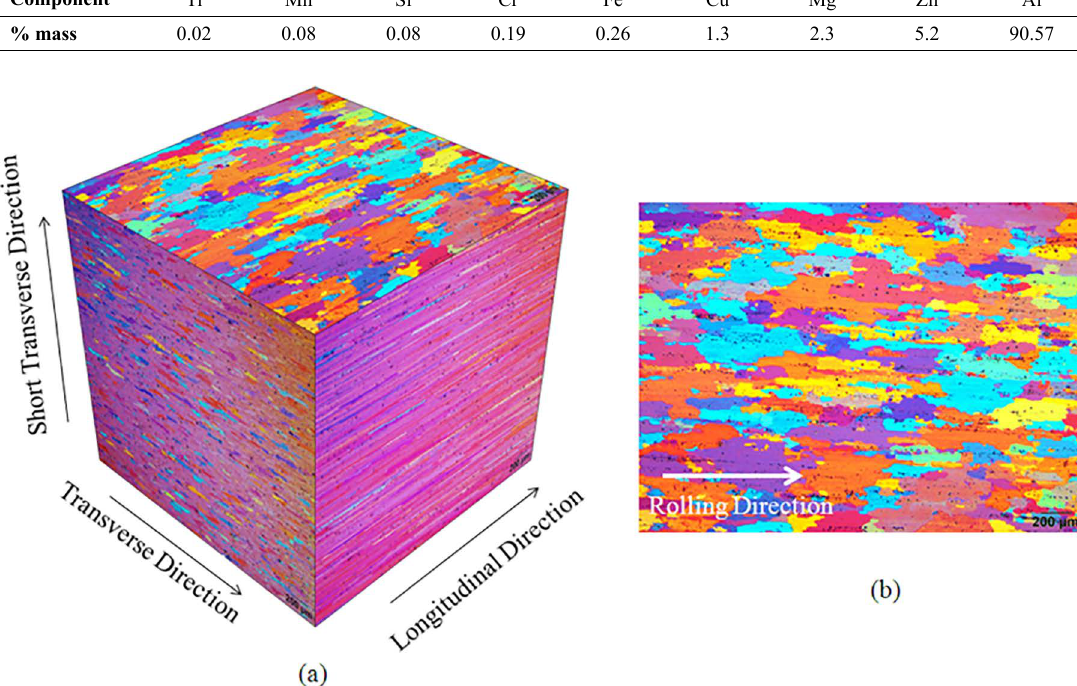
Figure 1. Microstructures of AA 7075 obtained by using polarized light microscopy. (a) views of three different planes and (b) a view of the rolling